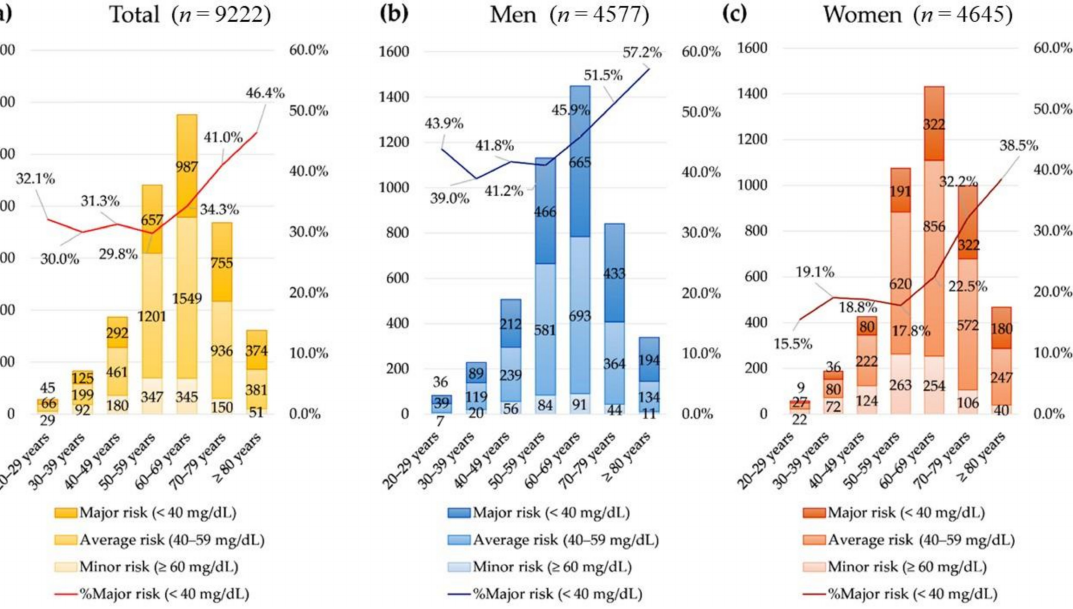
Figure 2. The prevalence of low HDL (HDL < 40 mg/dL) ( a ) in the total population, ( b ) in men, and ( c ) in